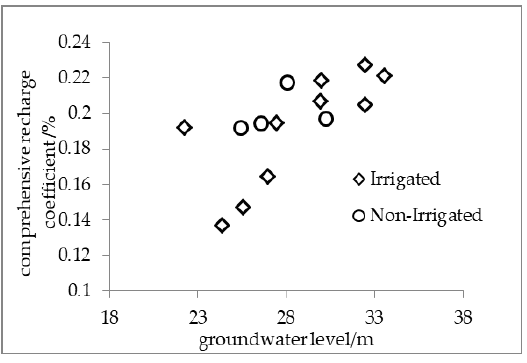
Figure 13. Correlation between groundwater level and comprehensive recharge coefficient.